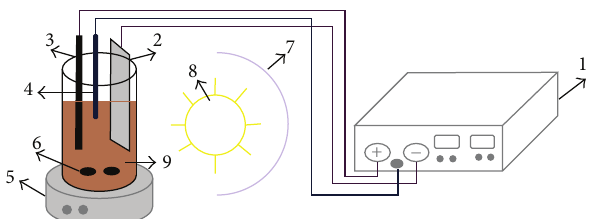
Figure 2: The electrochemical reactor and instrumentation. (1) DC power source, (2) Cu/N TiO 2 /Ti anode, (3) graphite cathode, (4) reference electrode, (5) magnetic stirrer, (6) magnetic bar stirrer, (7) aluminum foil, (8) tungsten lamp, and (9) sample